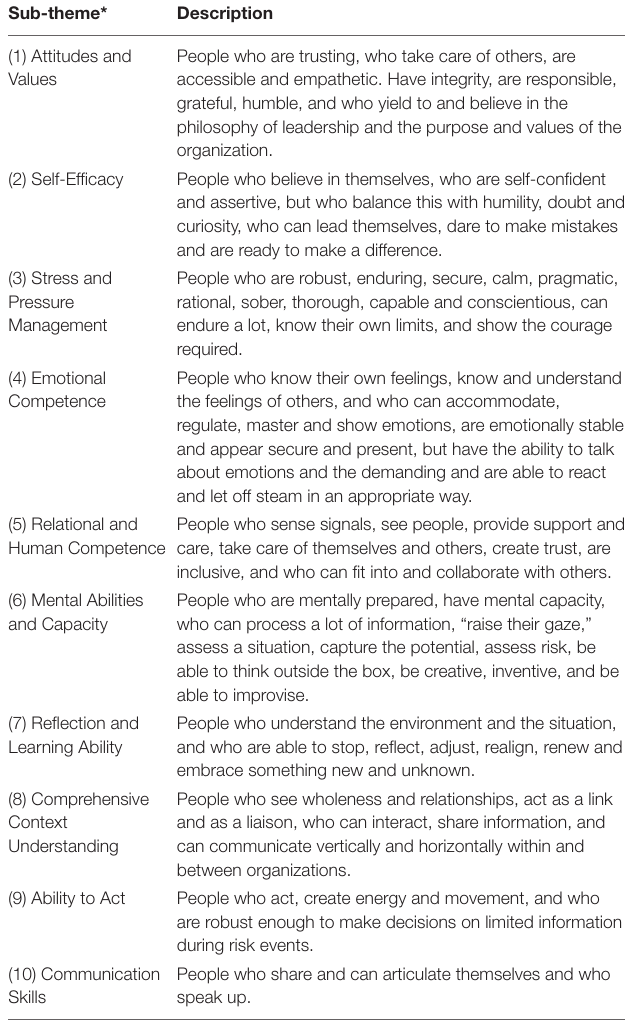
TABLE 5 | Communalities of characteristics and competence of the